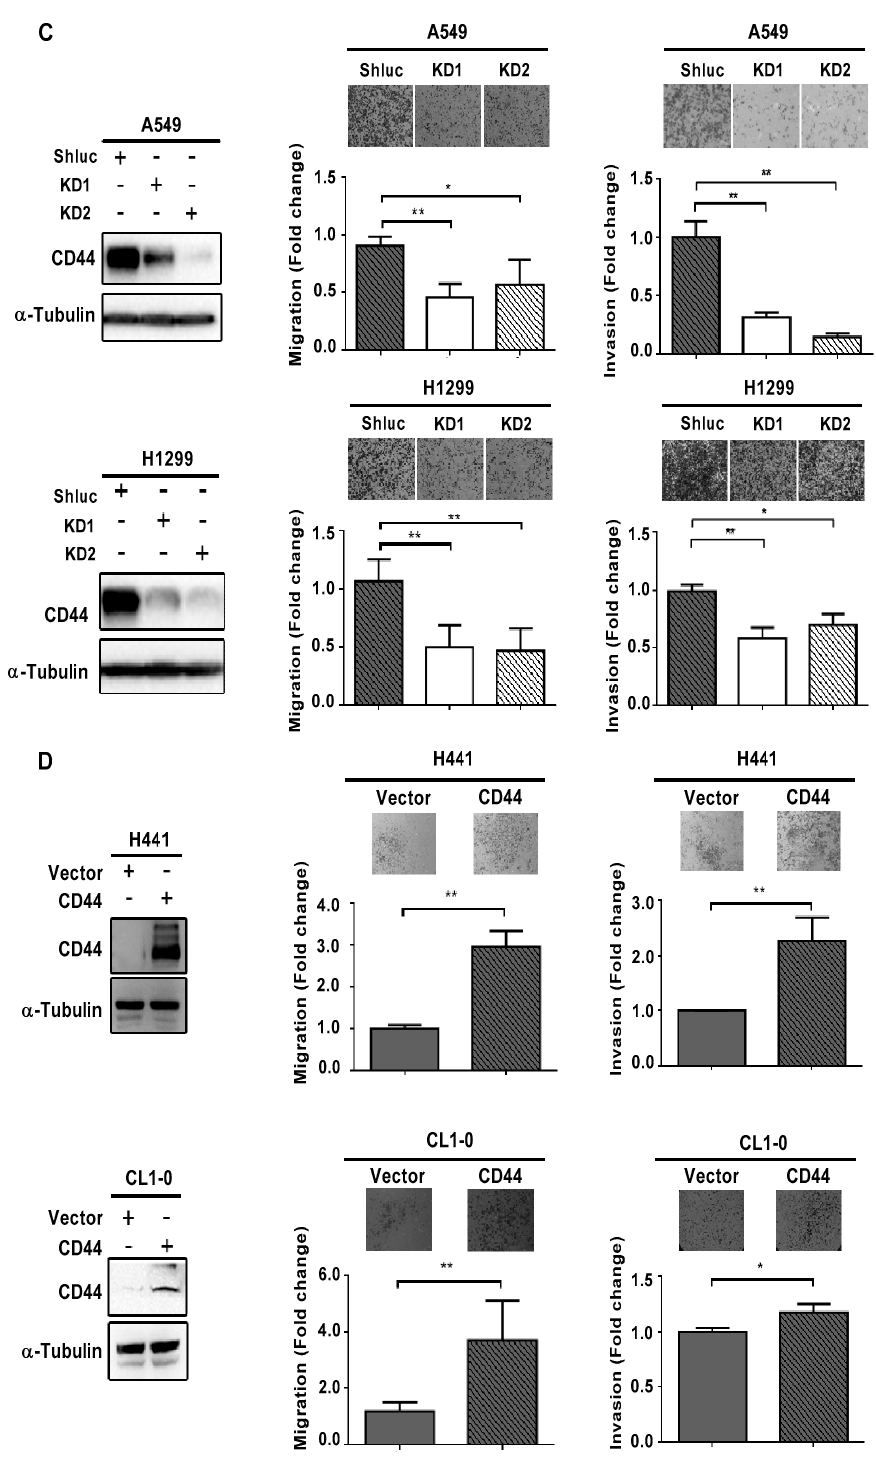
Figure 2. CD44 knockdown reduced migration and invasion abilities of lung cancer cells in vitro. ( A ) Expression of CD44 in different lung cancer cell lines and quantification of western data. ( B ) CD44 knockdown efficiency of different lentivirus clones and quantification of western data. ( C ) CD44 knockdown efficiency in A549 and H1299 cells determined by Western blot ( left ), and effects of CD44 knockdown on Transwell migration ( middle ) and invasion ( right ) abilities of A549 and H1299 cells. ( D ) CD44 overexpression efficiency in H441 and CL1-0 cells ( left ), and effects of CD44 overexpression on Transwell migration ( middle ) and invasion ( right ) abilities of H441 and CL1-0 cells. * p < 0.05, ** p <